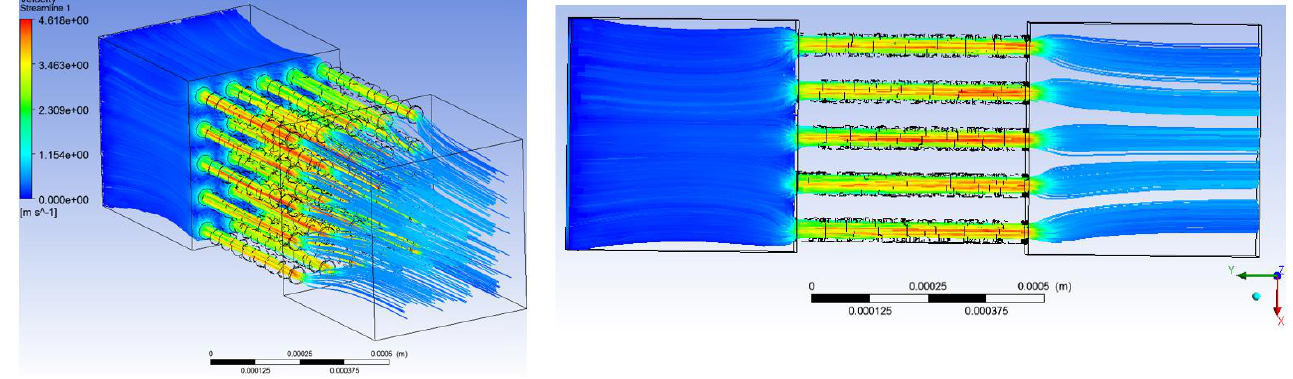
Figure 6. Streamlines of air flow velocity in model of case I—50 µ m of porous mycelium media in ( a ) perspective view and ( b ) profile